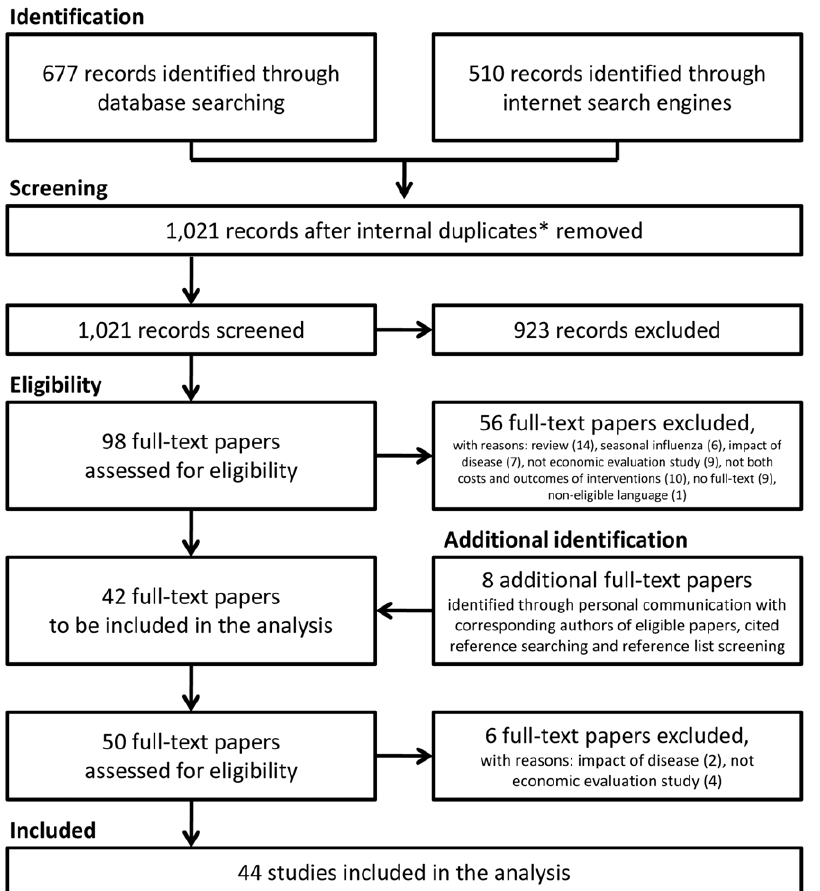
Figure 1. Flow of study selection. * Records duplicated inside an individual database or internet search results list. doi:10.1371/journal.pone.0030333.g001 PLoS ONE |